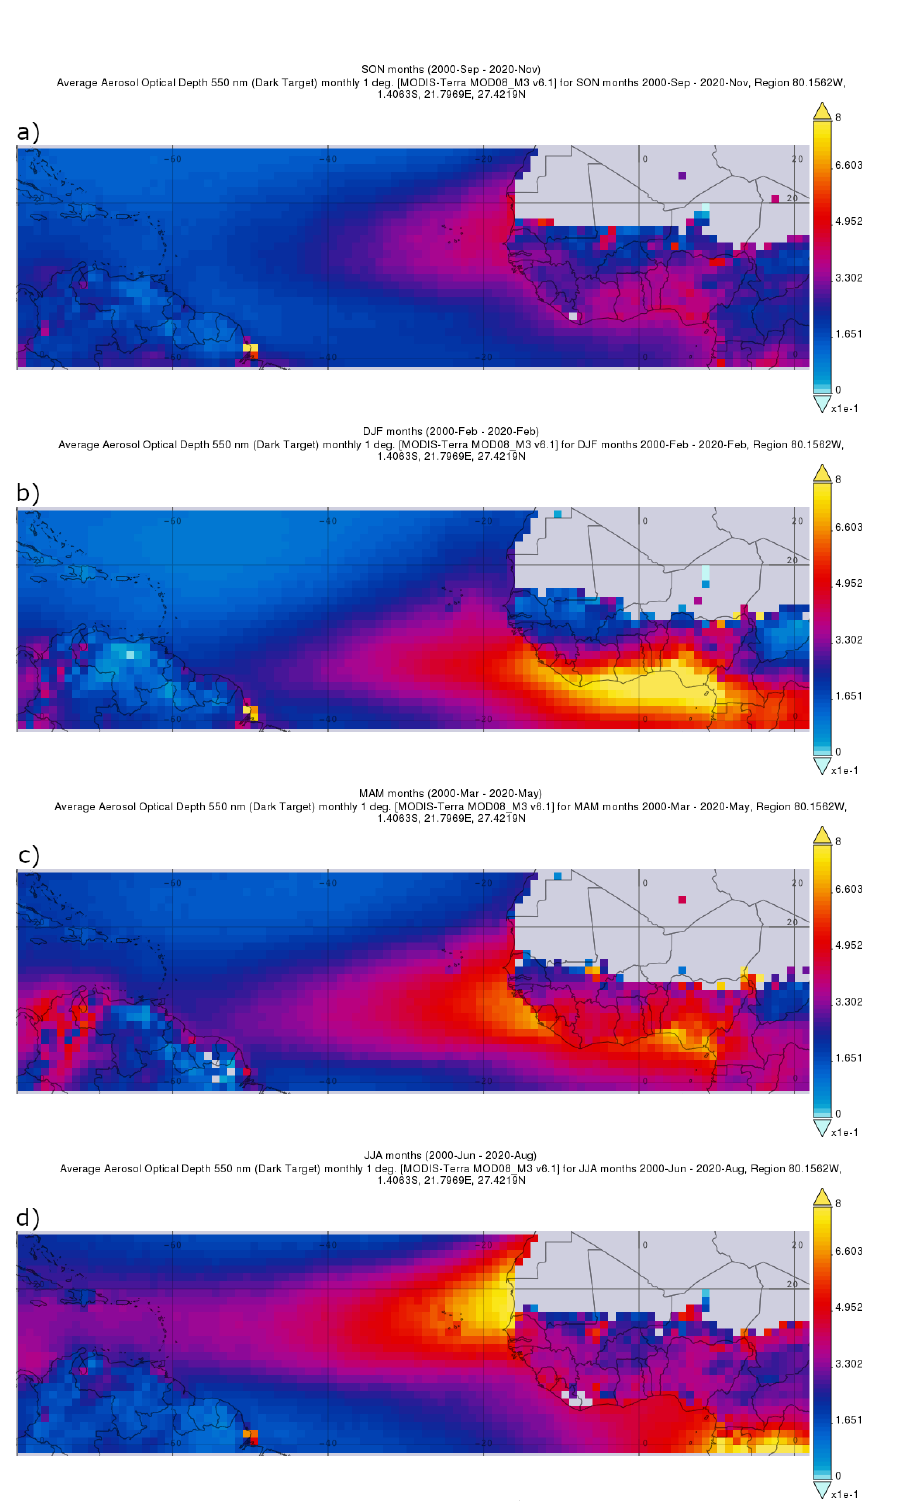
Figure 2. Seasonal satellite images from MODIS for the North Atlantic area with AOD monthly average between 2000 and 2020 for ( a ) September to November (SON), ( b ) December to February (DJF), ( c ) March to May (MAM), and ( d ) June to August (JJA). [NASA GIOVANNI (https://giovanni. gsfc.nasa.gov/giovanni/) (accessed on 20 January